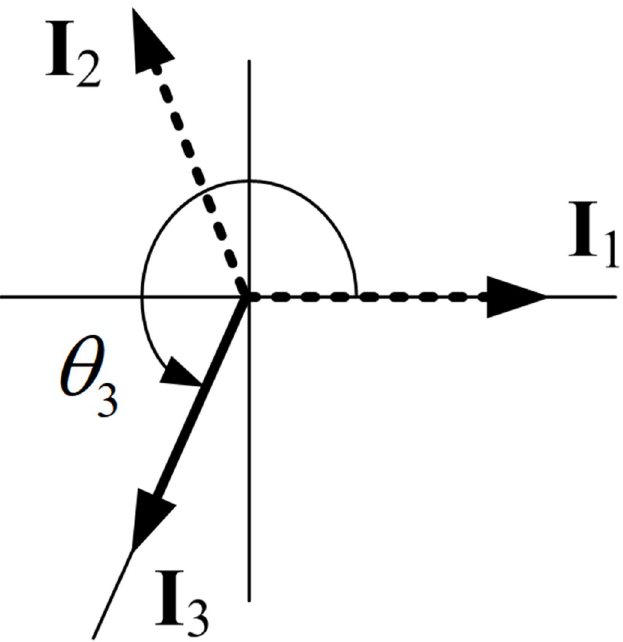
Fig 2. Impulse vector diagram of an SD shaper with a shaping time 0.5 < T s � 1. Because the shaping time T s is in 0.5 < T � 1, the SD shaper is composed of three s